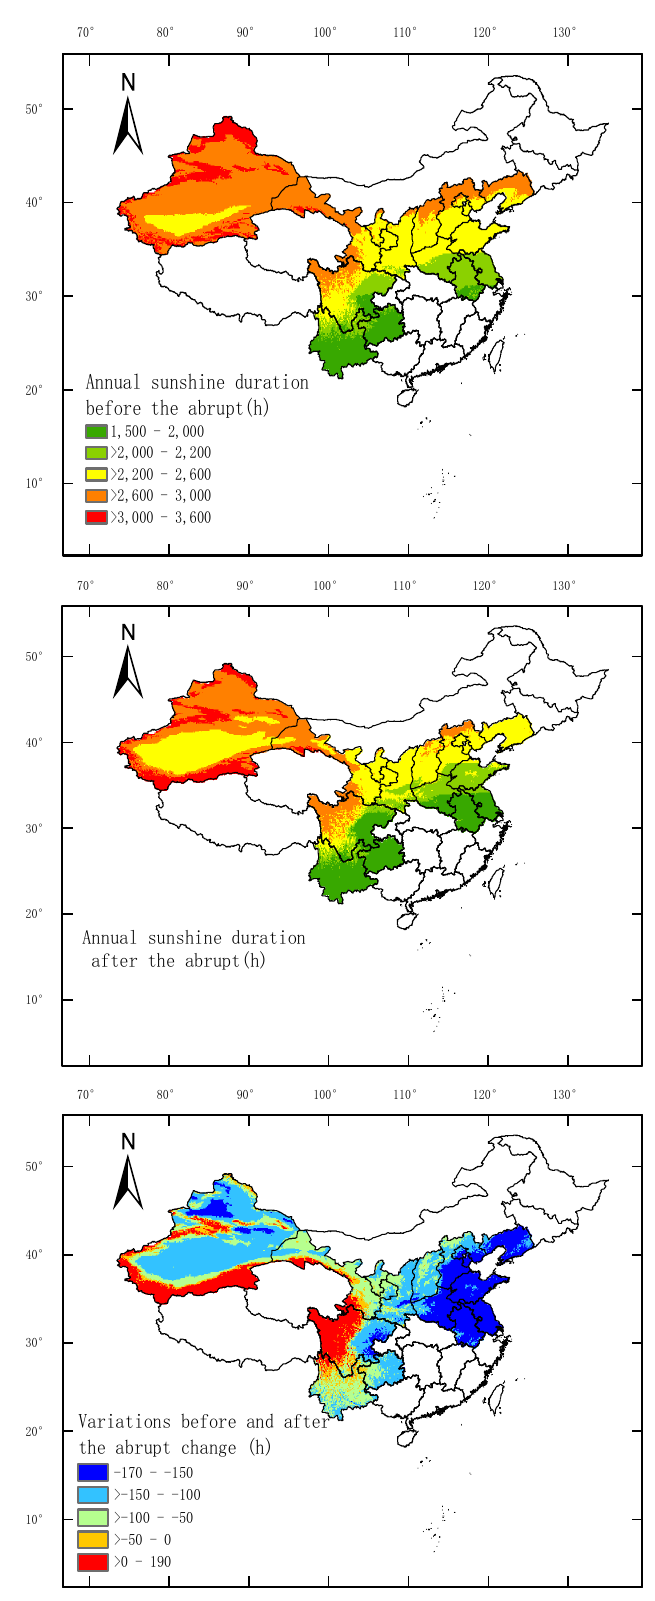
Figure 5. The changes in spatial distribution of the major apple-producing regions in China before and after the abrupt change of annual sunshine, wherein the yellow area represents the optimal range of annual sunshine for high-quality apple growing.